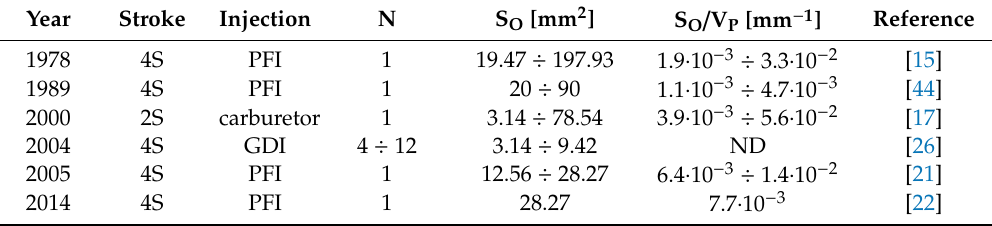
Table 3. Flow passage areas of the passive prechambers for gasoline engines known to the